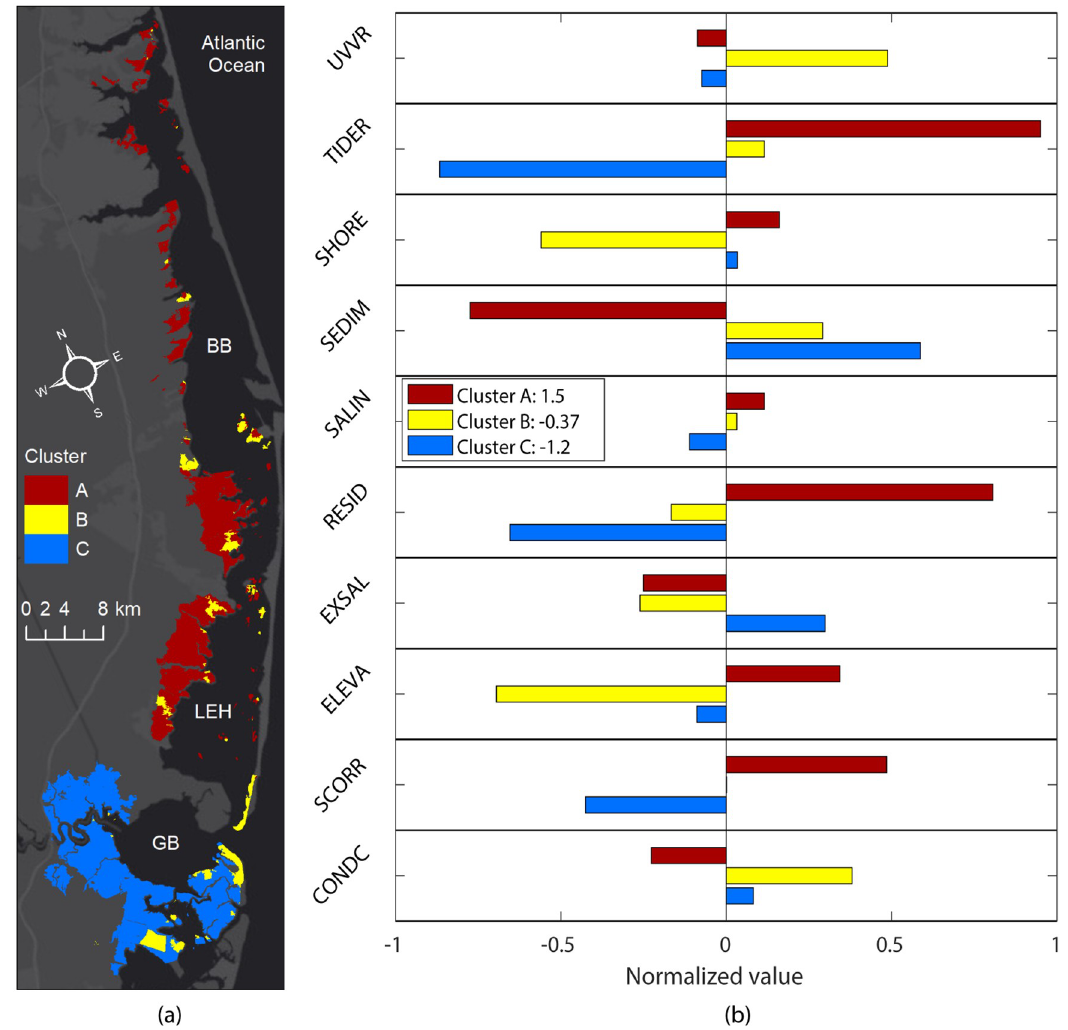
Fig 6. Cluster classification. a) Spatial distribution of the three clusters obtained using Expectation-Maximization to separate the sub-components. b) Departure from the mean of each indicator variable for all clusters. The values of the variables have been normalized with positive values representing cluster means higher than global average. A value of one represents a departure of one standard deviation from the global mean of that variable. The values in the legend represent the sum of all normalized contributions for each